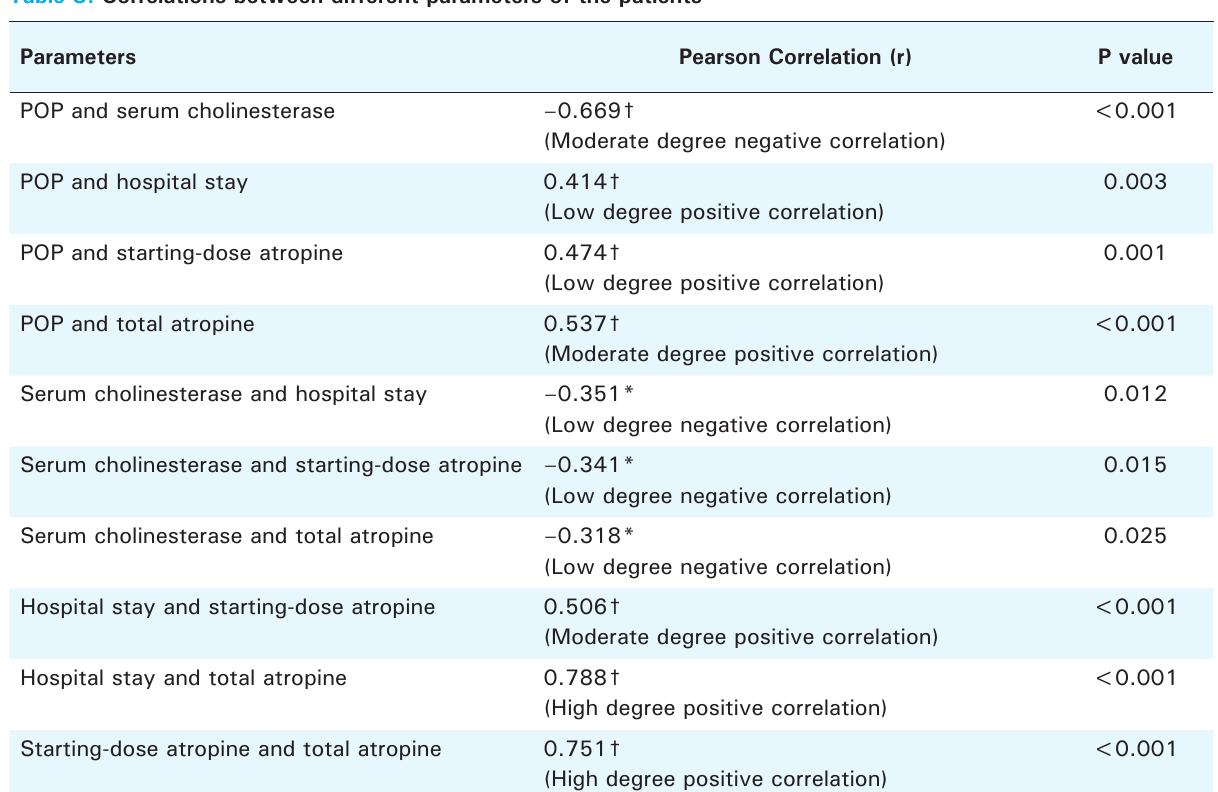
Rehiman et al. Cholinesterase and POP Scale in OP table 2. Values of different parameters in the three grades of poisoning as per the PoP scale PoP scale n (%) s. cholinesterase Mean (±sd)